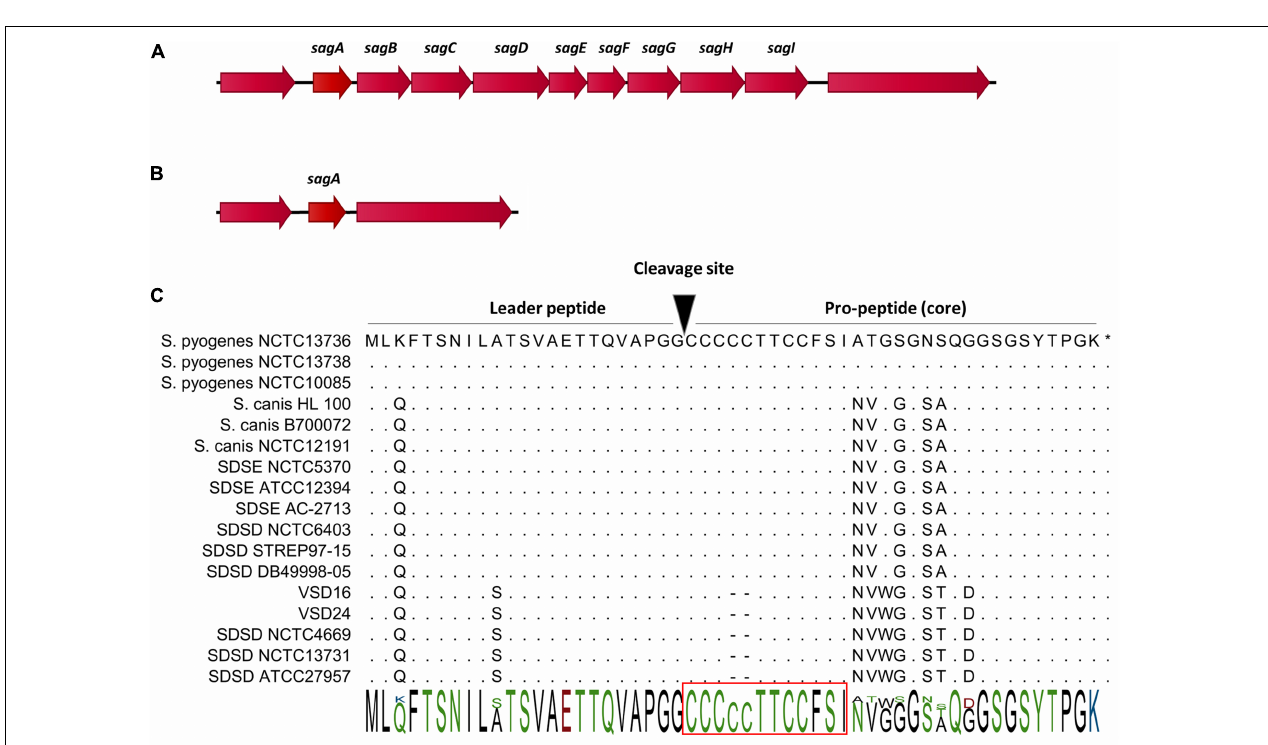
FIGURE 3 | Gene cluster organization of streptolysin S (SLS) operon and precursor peptide sequences of SLS cytolysins (SagA). (A) Organization of the SLS operon in Streptococcus dysgalactiae subsp. equisimilis (SDSE), human and fish S. dysgalactiae subsp. dysgalactiae (SDSD), Streptococcus pyogenes , and Streptococcus canis . The operon encoding SLS includes the prepropeptide structural gene ( sagA ), followed by eight genes responsible for the conversion of SagA into SLS ( sagBCD ), transport across the membrane ( sagFGHI ), and accountable for leader cleavage ( sagE ) (Datta et al., 2005). (B) Organization of the genomic region flanking sagA in bovine SDSD isolates. (C) Alignment of SagA peptide, the precursor of SLS. SLS core region possesses a highly conserved N-terminus, while the C-terminus is more variable. The putative leader peptide cleavage site is shown. Red rectangle, minimal core region required for hemolytic activity of SLS in S. pyogenes . STAB-Vida performed sequencing of sagA. Deduced amino acid sequences from this bovine allele were compared with sequences from the National Center for Biotechnology Information (NCBI) database and were analyzed with the CLC-bio Main Workbench sequence alignment tool (QIAGEN, Netherlands).